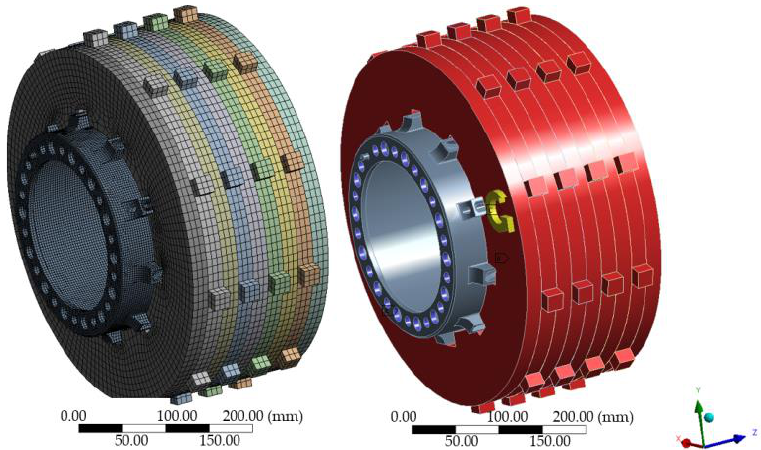
Figure 6. Finite element model and application of the boundary condition .